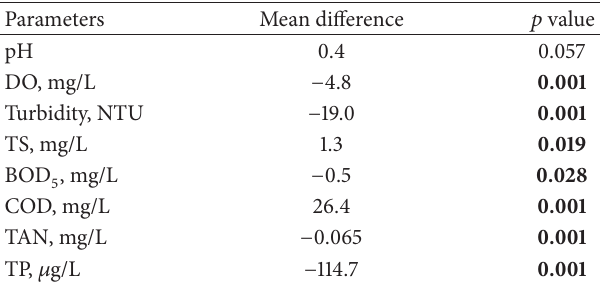
Table 2: Mean difference in water quality parameters between closed and opened spillway when the Bakun hydroelectric dam is in operation ( 𝑁 = 5